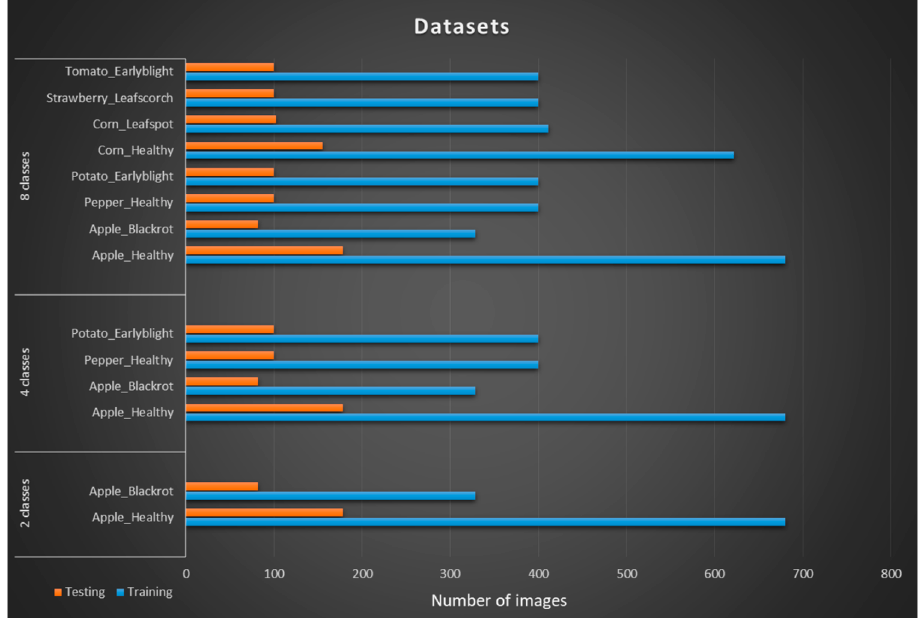
Figure 6. Information of the plant leaf dataset. The complete dataset is divided into four categories with two, four, and eight